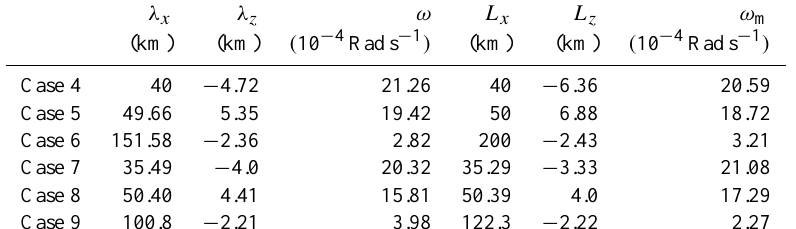
Table 4. Comparison between the calculated wavelengths and frequencies of the excited waves and their matching values in cases 4–9.